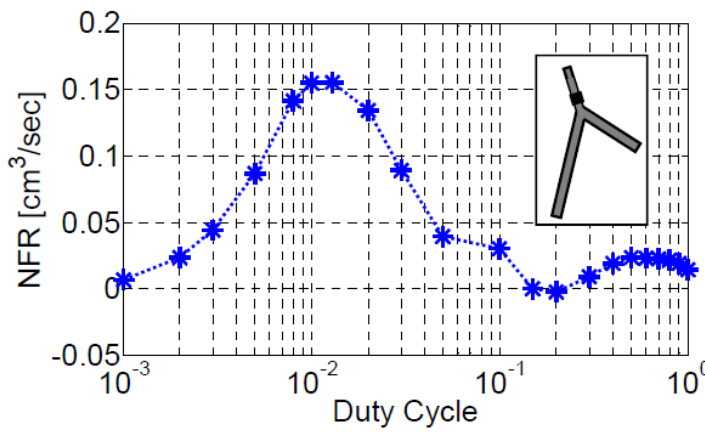
Figure 8. The dependence of NFR on the actuator duty cycle for configuration III-b. The actuator was located on the first vessel at X C / L = 0.75. Actuation frequency was 4.4 Hz, close to the fourth natural frequency of the system.